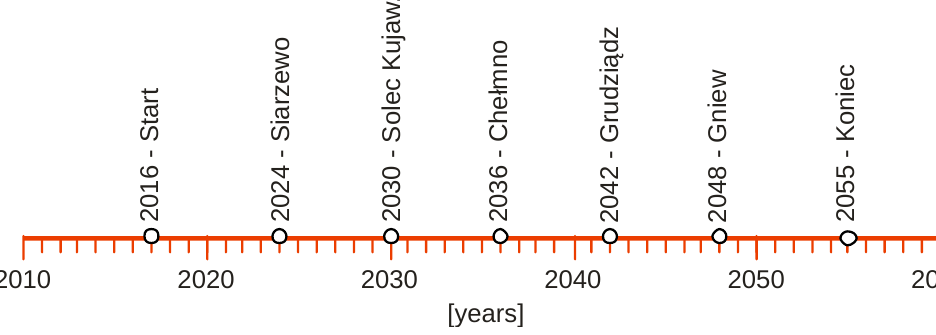
Figure 8. Time schedule of the planned cascade of the Lower Vistula